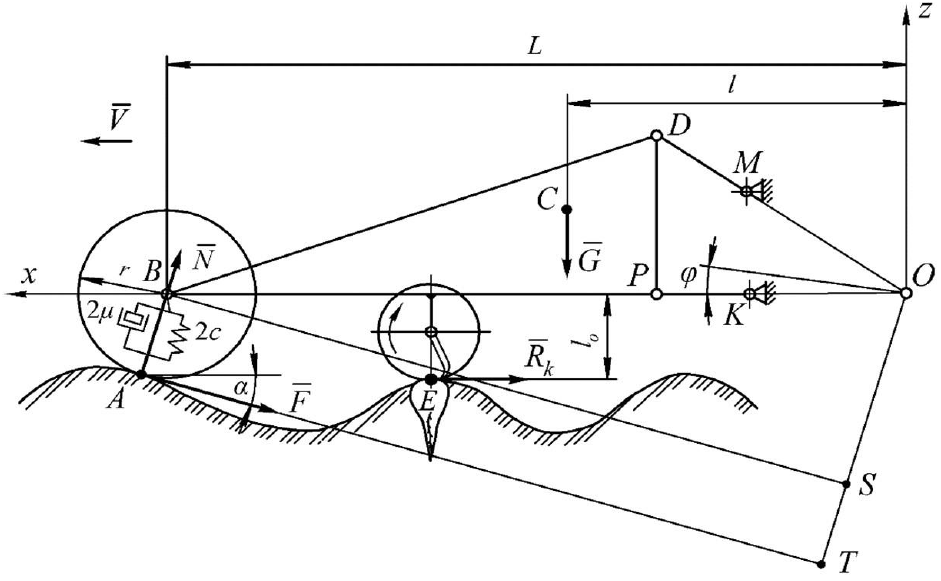
Figure 2. Equivalent scheme of leaves harvesting machine attached to the front of the aggregating tractor.